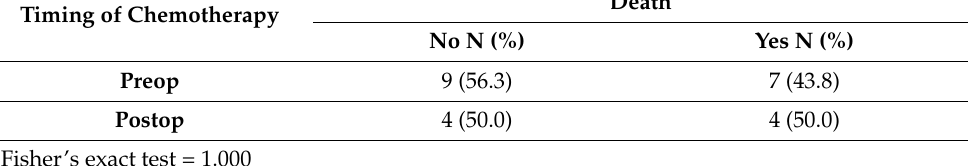
Fisher’s exact test = 1.000